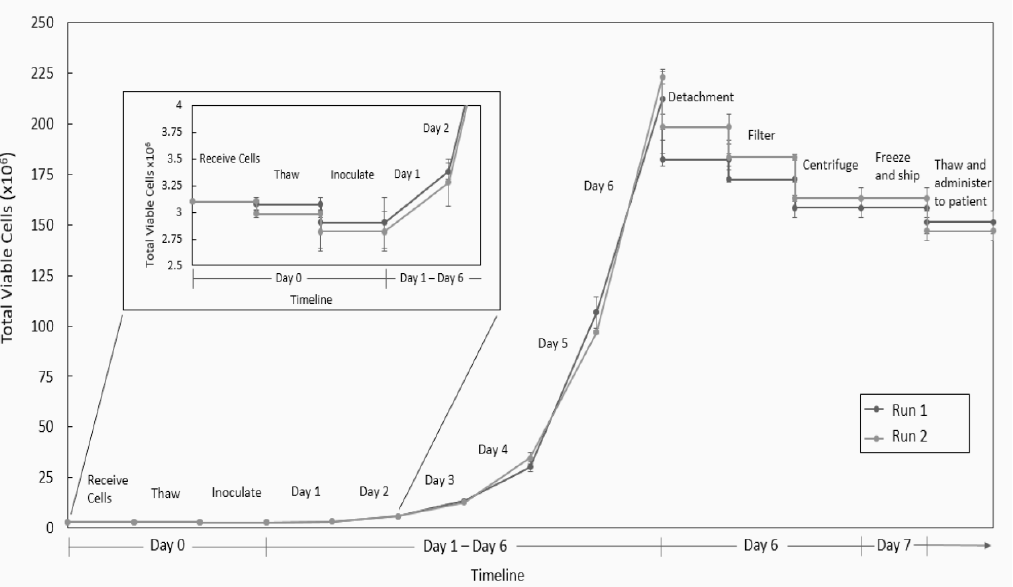
Figure 7. Overall process of Sk-SCs expanded in 500 mL DASGIP bioreactors. Two independent